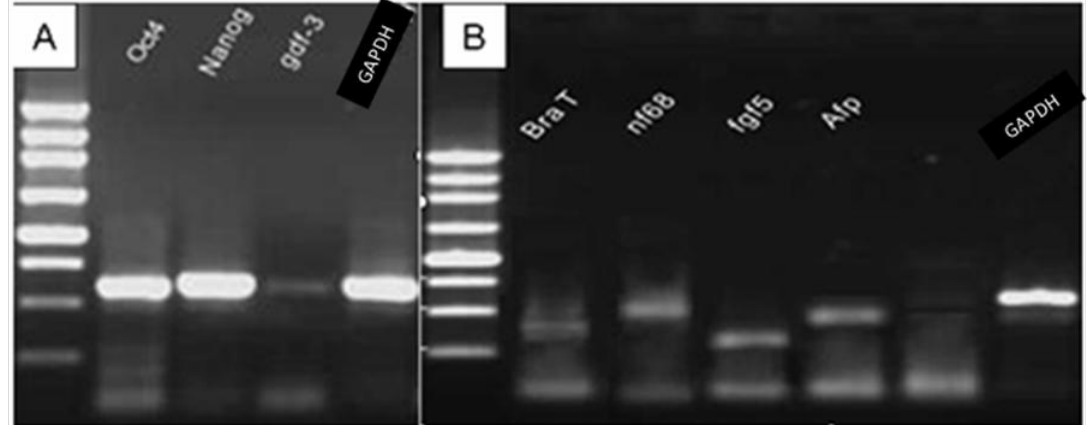
Figure 3. RT-PCR analysis of the expressed marker molecules in the ES cells and the specific genes for three germ layers in the ES cell-derived embryoid bodies. ( A ) dictated the ES cells expressed Oct 4, Nanog and Gdf -3; and ( B ) dictated the embryoid bodies (EBs) expressed these specific genes: BraT for mesoderm, Nf- 68 and Fgf- 5 for ectoderm, Afp for endoderm, and GAPDH as the positive control.